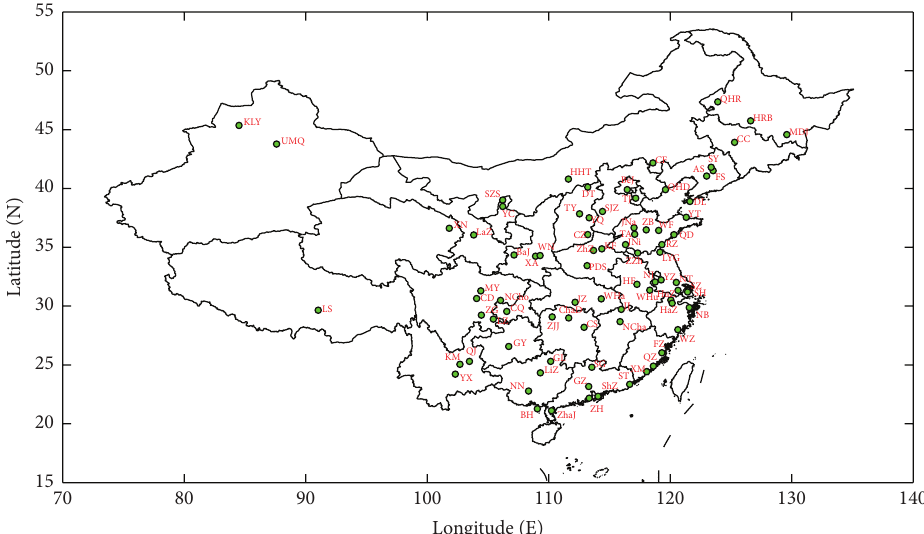
Figure 1: The computing area and locations of the 82 cities in which observations are available. Full names of these cities can be found in